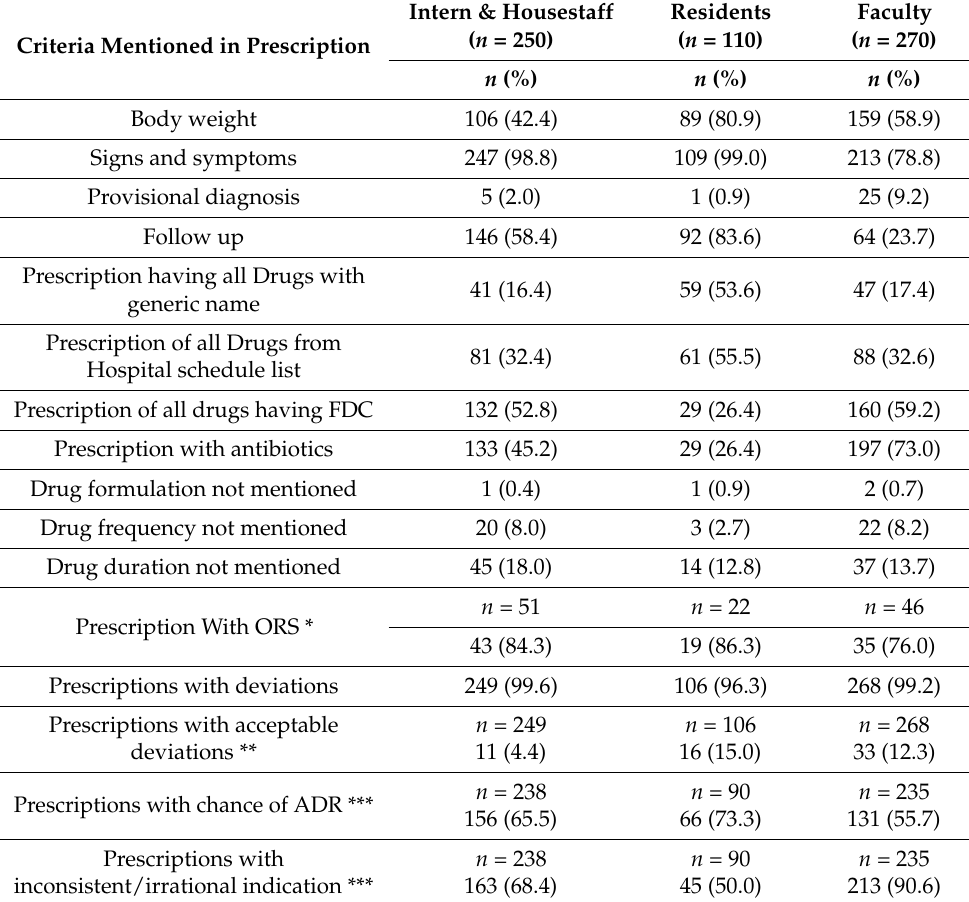
Table 5. Completeness of prescriptions as per different criteria across types of